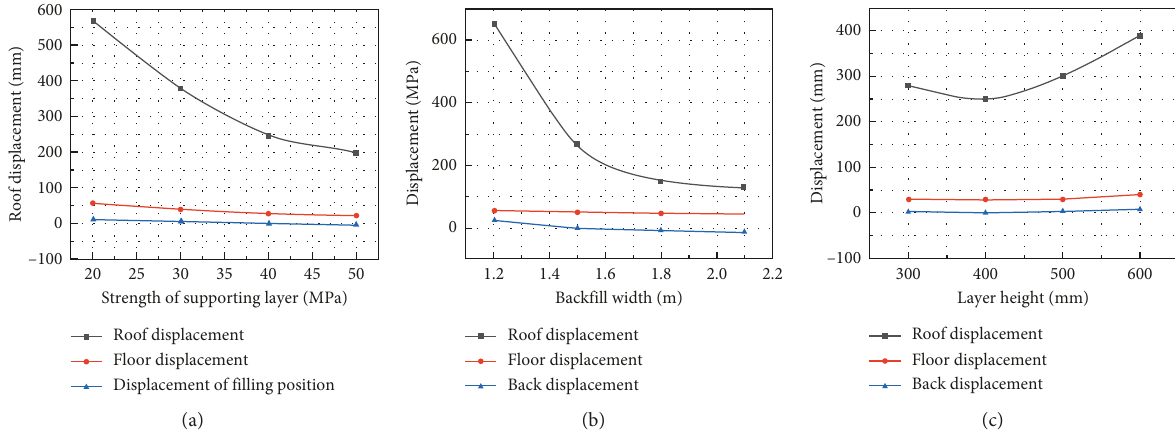
Figure 7: Displacement of surrounding rock and filling body under different influence factors of “composite wall.” (a) Strengthen influence. (b) Width influence. (c) Height